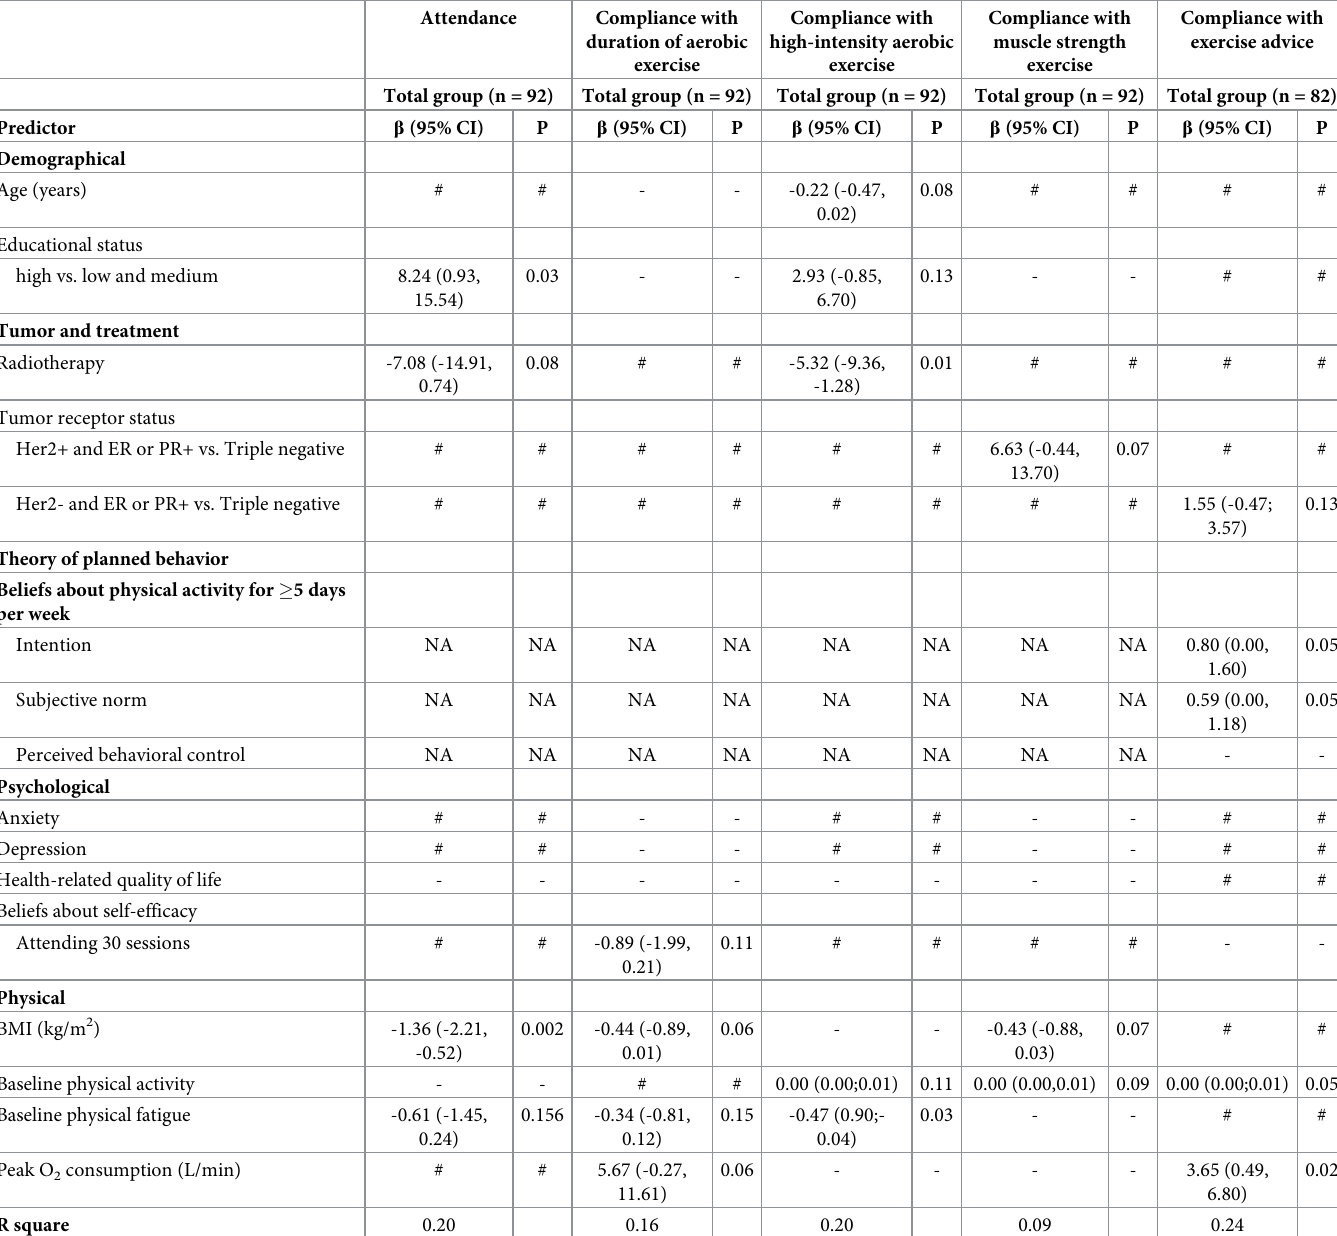
Table 3. Multivariable linear regression analyses on the association between selected predictors and attendance and compliance.